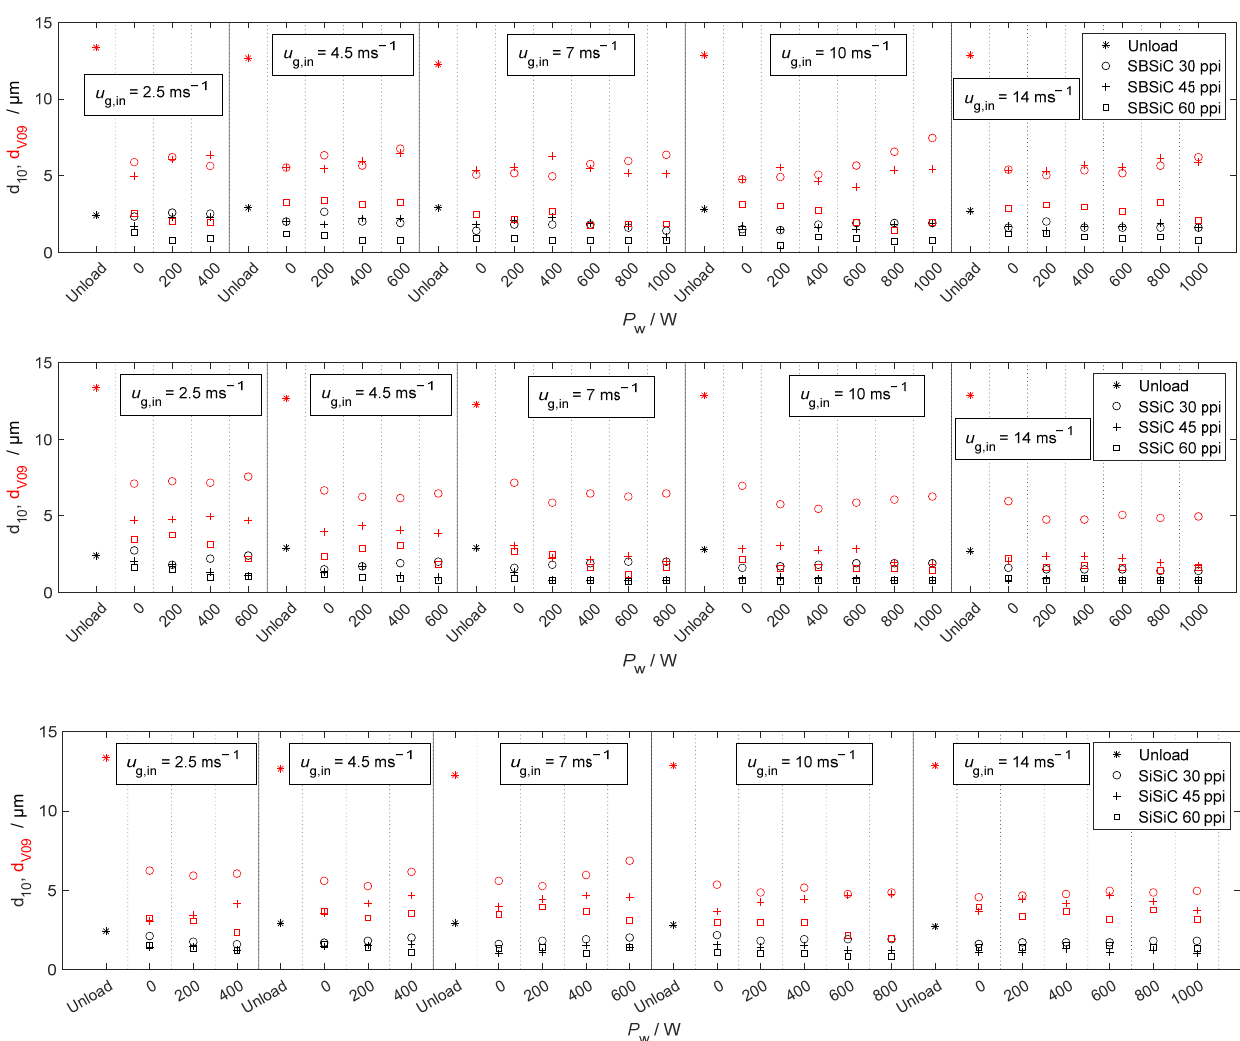
Figure 10. Diameters d 10 and d V 09 (red symbols) of droplets crossing the outlet position of the microwave applicator loaded with SBSiC ( top ), SSiC ( middle ) and SiSiC ( bottom ) foams at an input magnetron power up to 1 kW.